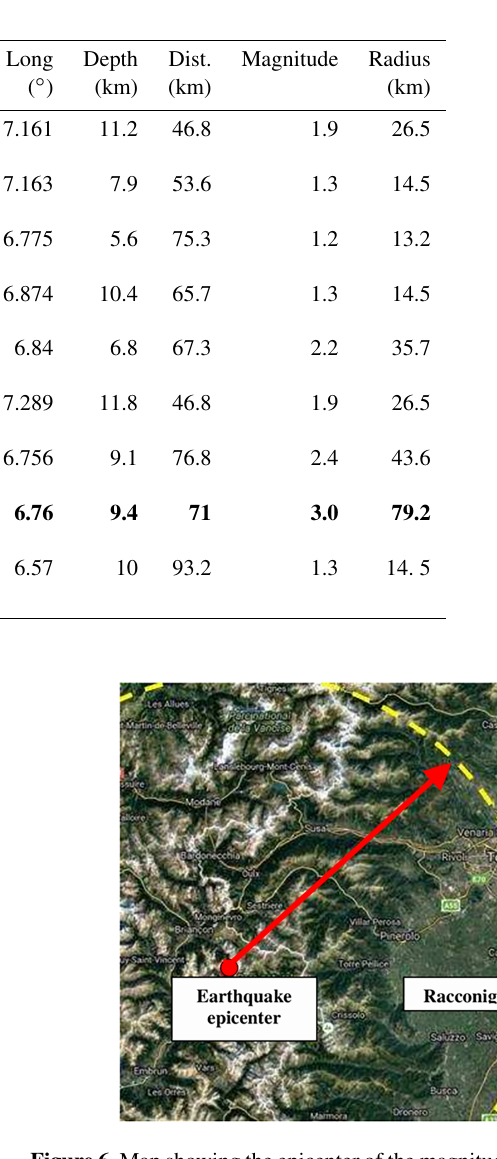
Figure 5. Evolution of natural-time quantities κ 1 (blue line) and S (red line) as functions of accumulated AE hit number N . The hori- zontal dashed line indicates the value κ 1 = 00 . 07, while the vertical line indicates the corresponding criticality initiation hit ( N = 104). The upper dash-dot line indicates the entropy limit S u = 0 . 0966.